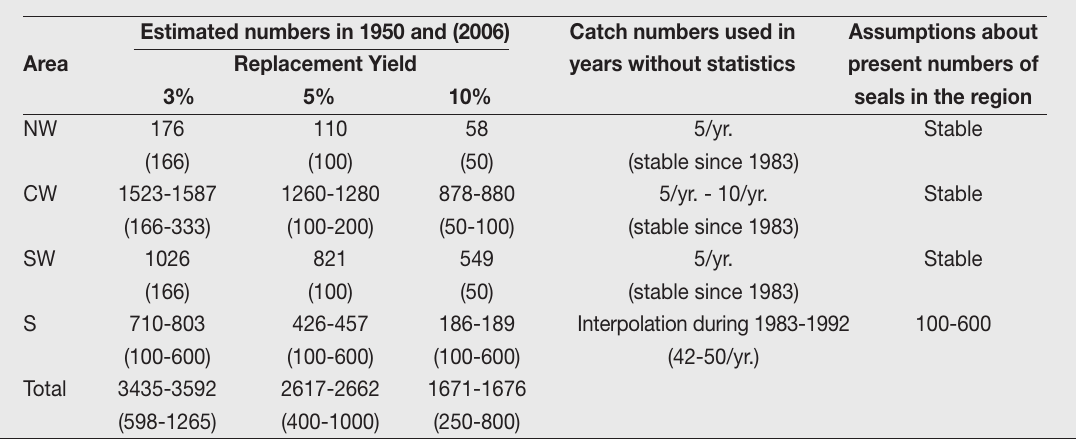
Table 1. Estimated harbour seal numbers in 1950 and 2006 based on back-calculations (N t+1 = N t + (replacement yield (N t) – catch